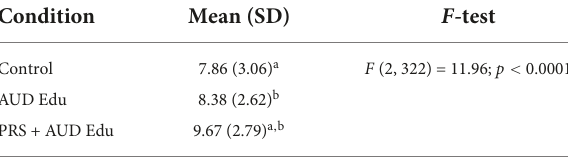
TABLE 3 Mean (SD) understanding of polygenic risk scores for alcohol use disorder across the three conditions of the randomized controlled trial.